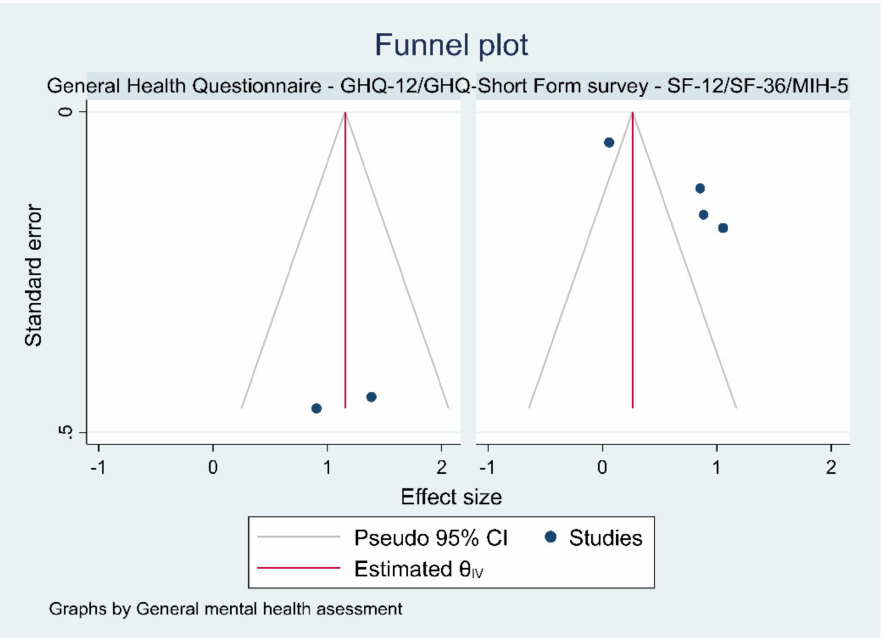
Figure A8. Funnel plot—general mental